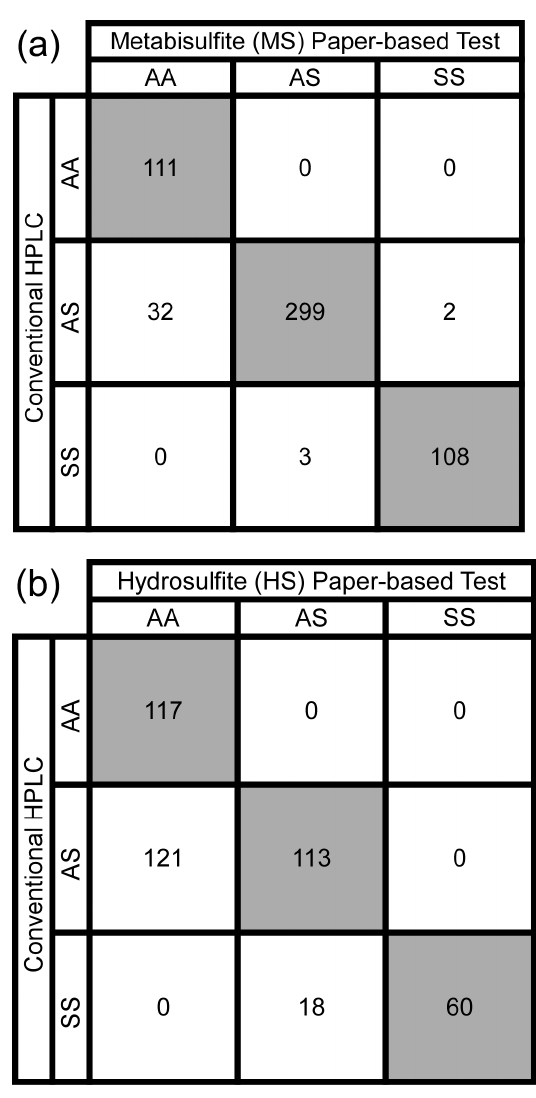
Figure 2. Diagnostic accuracy of the paper-based SCA screening test kit. ( a ) Aggregate confusion matrix for screening of blood samples ( n = 185) with characteristic HbS concentrations via visual interpretation (inexperienced users; n = 3) of the blood stains produced on paper by the metabisulfite (MS) formulation of the test (185 samples × 3 users = 555 total scores). ( b ) Aggregate confusion matrix for the screening of blood samples ( n = 143) with characteristic HbS concentrations via visual interpretation (inexperienced users; n = 3) of the blood stains produced on paper by the hydrosulfite (HS) formulation of the test (143 samples × 3 users = 429 total scores). Rows correspond to characteristic genotypes (based on HbS concentration measured using conventional high-performance liquid chromatography—HPLC) and columns correspond to predicted genotypes (diagnosed by the paper-based test). Shaded cells contain the numbers of correct diagnoses.